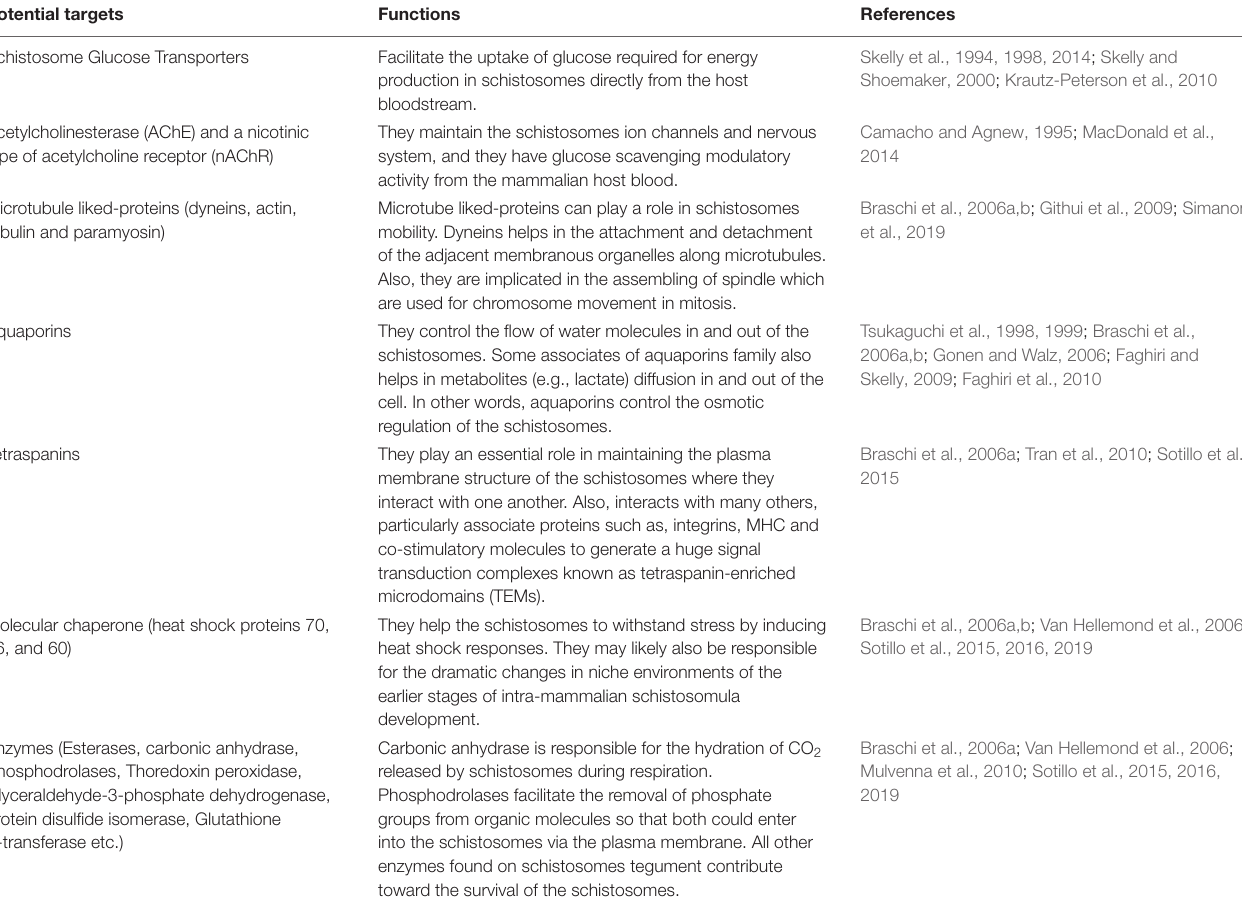
TABLE 2 | Different potential targets found on the schistosomes tegument for conjugated nanoparticles and their functions. Potential